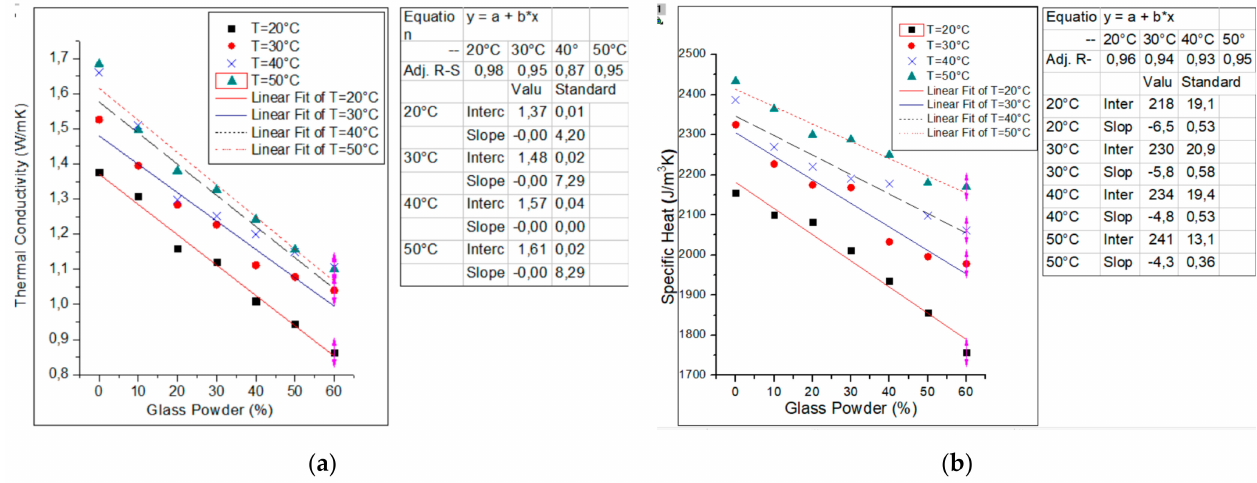
Figure 10. Variation of the measured thermal conductivity ( a ) and specific heat ( b ) with the glass powder content at different temperature